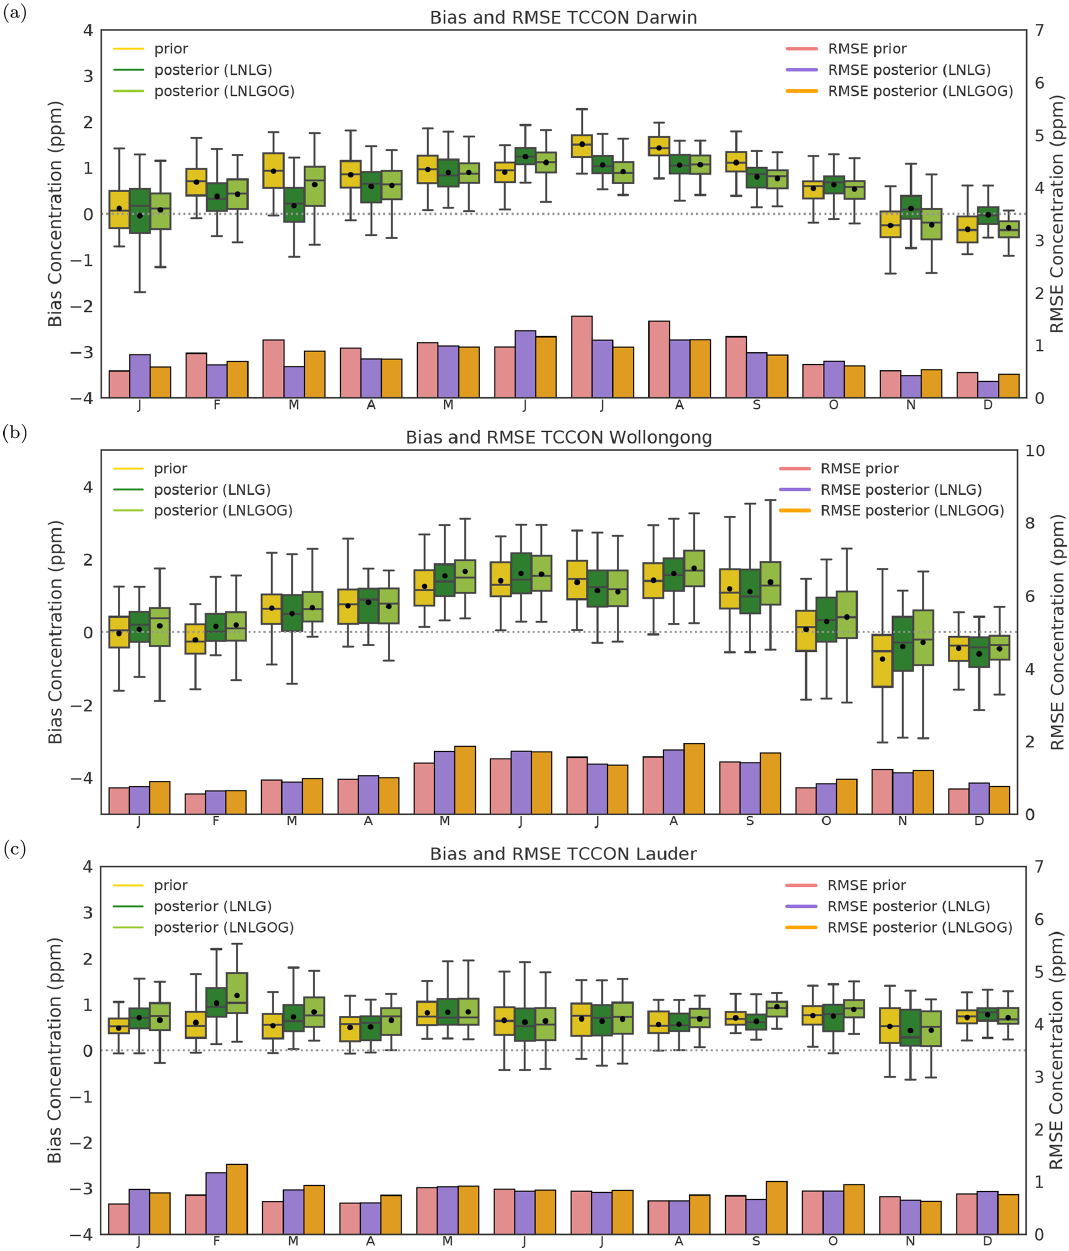
Figure 11. CMAQ prior and posterior concentration bias and root mean square error at the (a) Darwin, (b) Wollongong and (c) Lauder TCCON sites for 2015. Yellow-green and green boxes represent prior posterior concentration biases, and coral and purple bars represent the RMSE. Box plots represent the 75th percentile and the bottom edge represents the 25th percentile. The top and bottom whiskers represent the 95th and 5th percentiles. The horizontal black line shows the median and the circle indicates the mean. Mean values are indicated by black circles and median values by the black